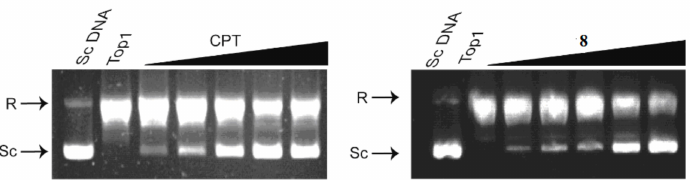
Figure 3. The representive gels for Top1-mediated relaxation assay. Lane 1, pBR322 DNA alone; Lane 2, pBR322 DNA and Top1 without compound; Lanes 3–7, pBR322 DNA, Top1 and compounds at 0.2, 1, 5, 25, 125 µ M, respectively. R, relaxed DNA; Sc, supercoiled DNA.